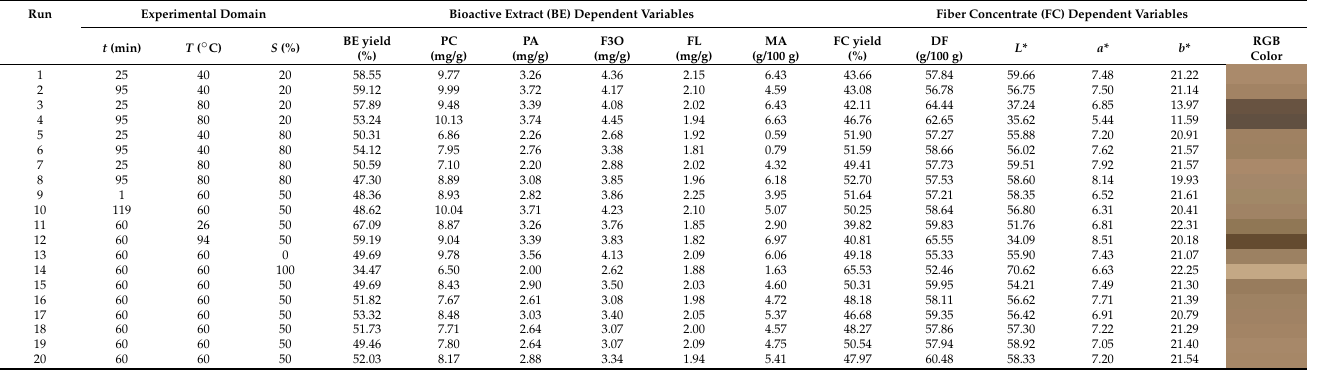
Table 2. Extraction yields, phenolic compounds and malic acid contents of bioactive extracts (BEs), and dietary fiber content and color parameters of fiber concentrates (FCs) obtained experimentally from quince peel with the 20 runs of the